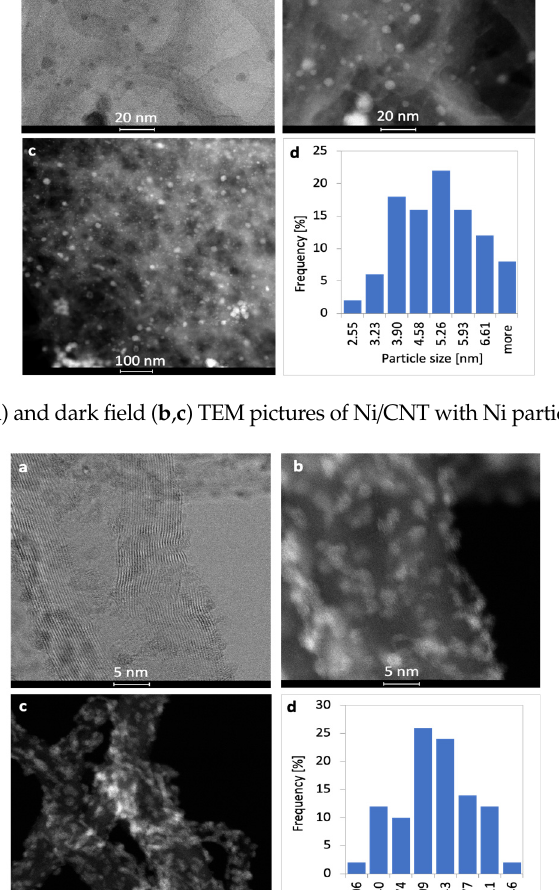
Figure 5. The Ce, Zr and Ni mapping for NiCZ/CNT ( a ) and selected area electron diffraction for Ni and CeZrO 2 nanocrystals supported over CNTs ( b ).